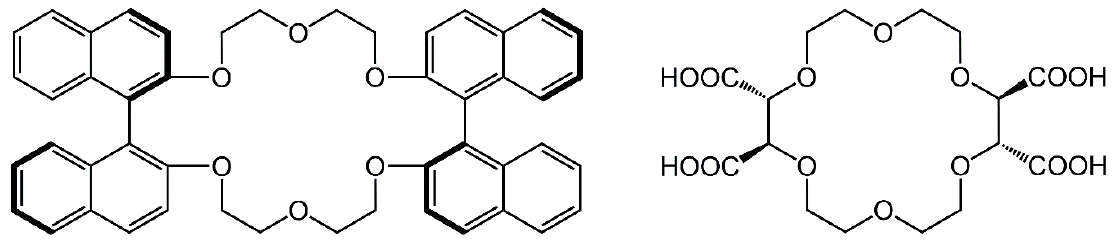
Figure 1. The structures of ( R,R )-bis-(1,1′-binaphthyl)-22-crown-6 (left) and ( + )-(18-crown-6)-2,3,11,12-tetracarboxylic acid (right).